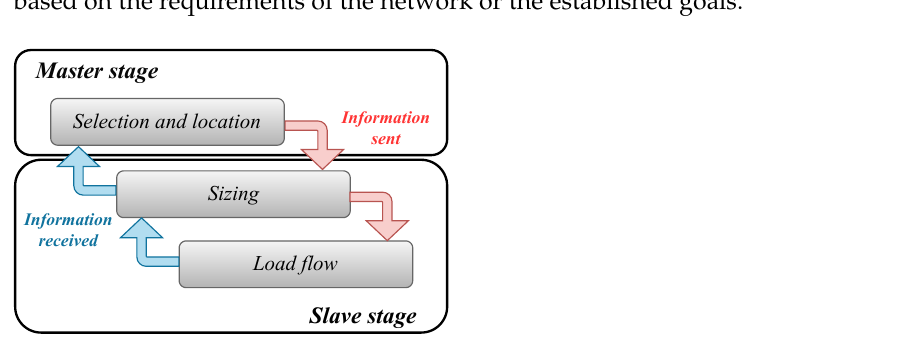
Figure 3. Master–slave methodology for the proper integration of DGs and ESSs into distribution